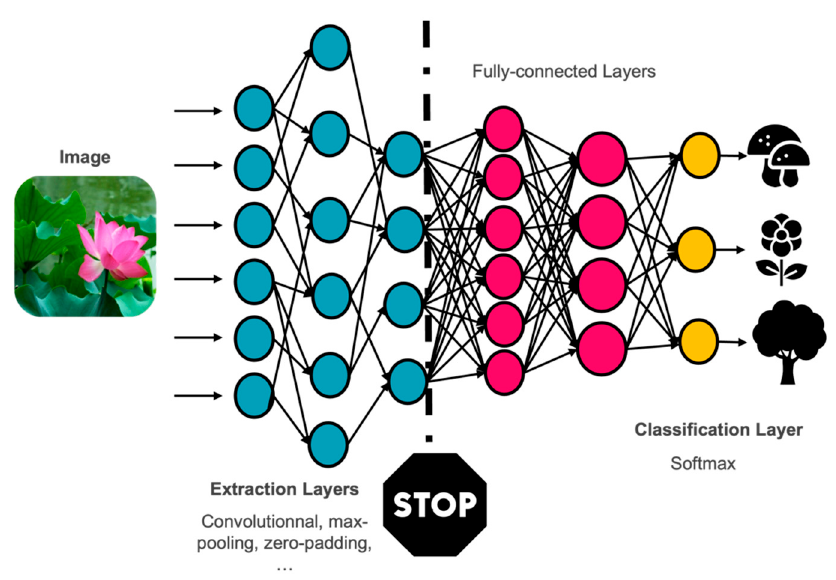
Figure 1. Illustration of position for extraction feature vectors after the last convolutional layer.